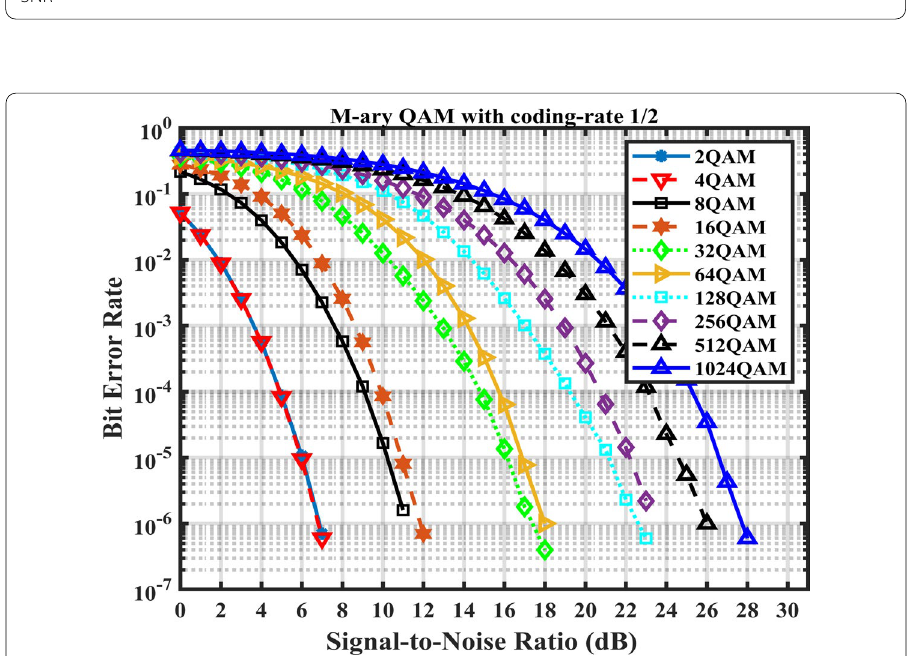
Fig. 12 BER versus SNR for different M-ary QAM with 1/2 code rate. This graph depicts the performance of different M-ary QAM with 1/2 code rate combination. The performance is described in terms of BER